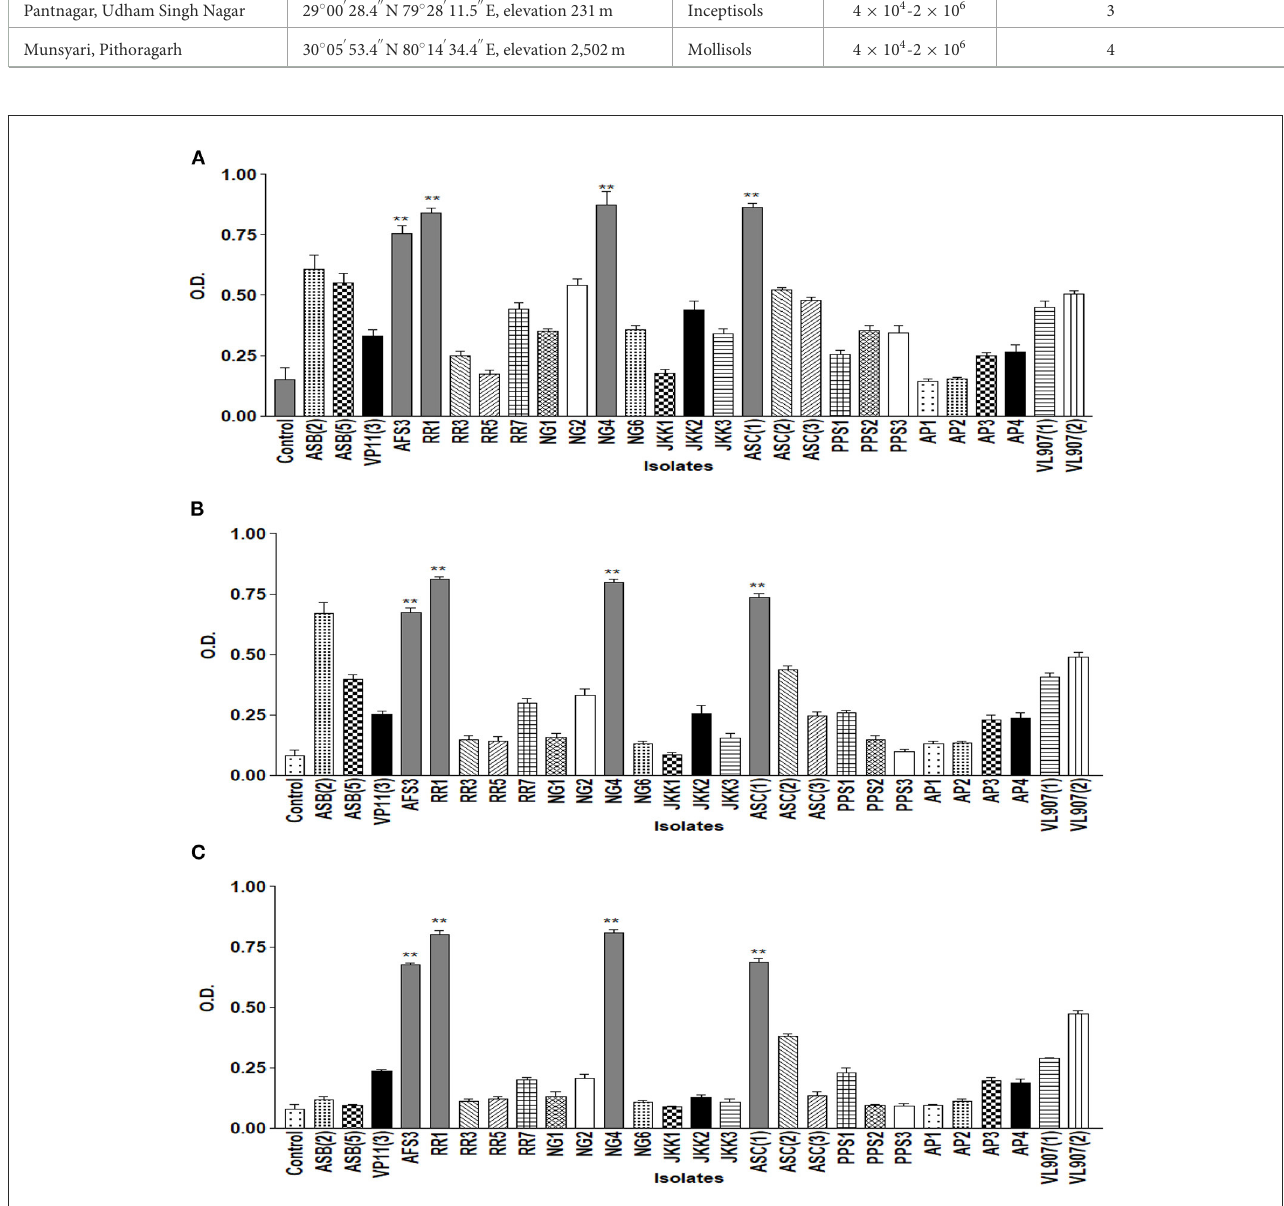
FIGURE2 Graph showing growth curve at different concentrations of PEG (A) 15%; (B) 25%; (C) 35% of all 27 isolates. ** = p value <